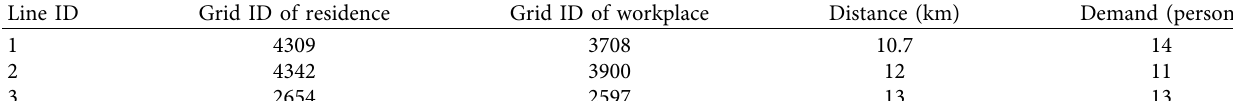
Figure 5: High hotspot grids and potential travel demand distribution. (a) High hotspot grids. (b) Potential travel demand distribution heat map. Table 3: Line information of example.